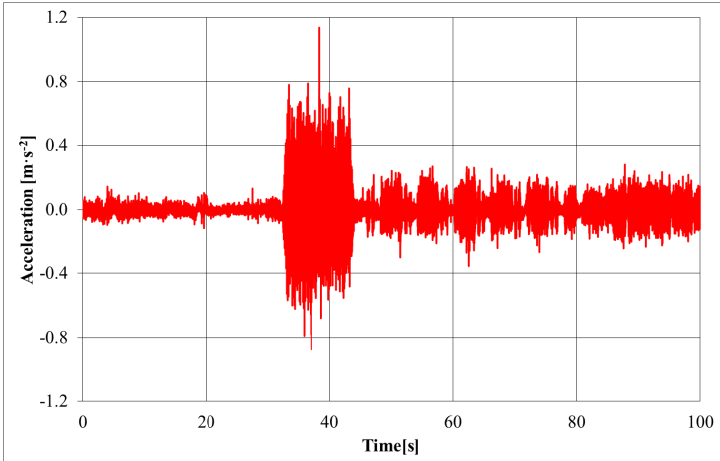
Matchweek Rival